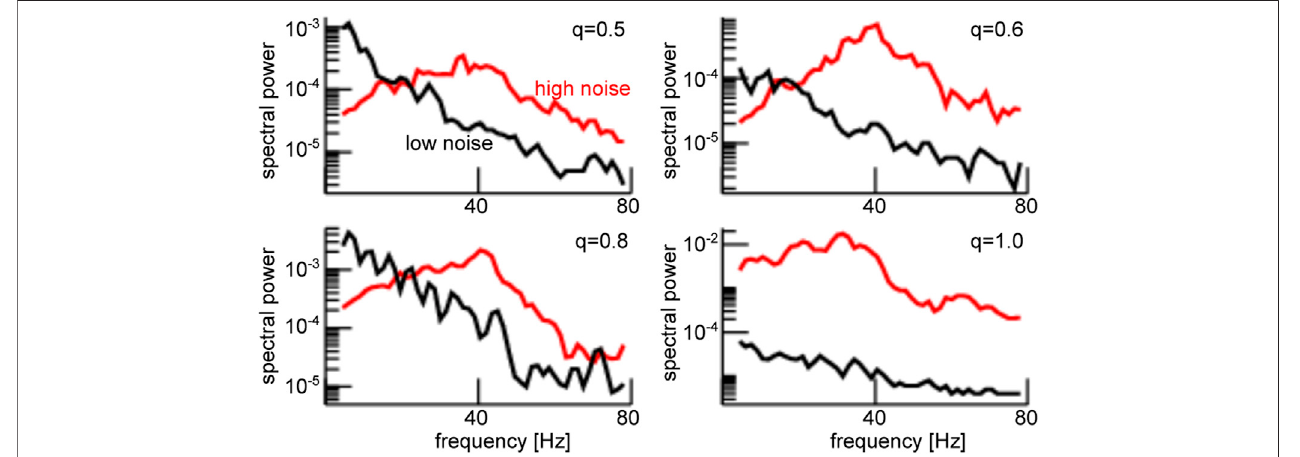
FIGURE 5 | Enhanced noise yields strong power of the global mode V ( t ) in the γ -frequency range. The panels show the power spectra of V for the stimulus ratios q (cid:1) 0 . 5 ( D 1 / τ e (cid:1) 0 . 35 (black) and D 1 / τ e (cid:1) 0 . 55 (red)), q (cid:1) 0 . 6 ( D 1 / τ e (cid:1) 0 . 25 (black) and D 1 / τ e (cid:1) 0 . 33 (red)), q (cid:1) 0 . 8 ( D 1 / τ e (cid:1) 0 . 20 (black) and D 1 / τ e (cid:1) 0 . 25 (red)) and